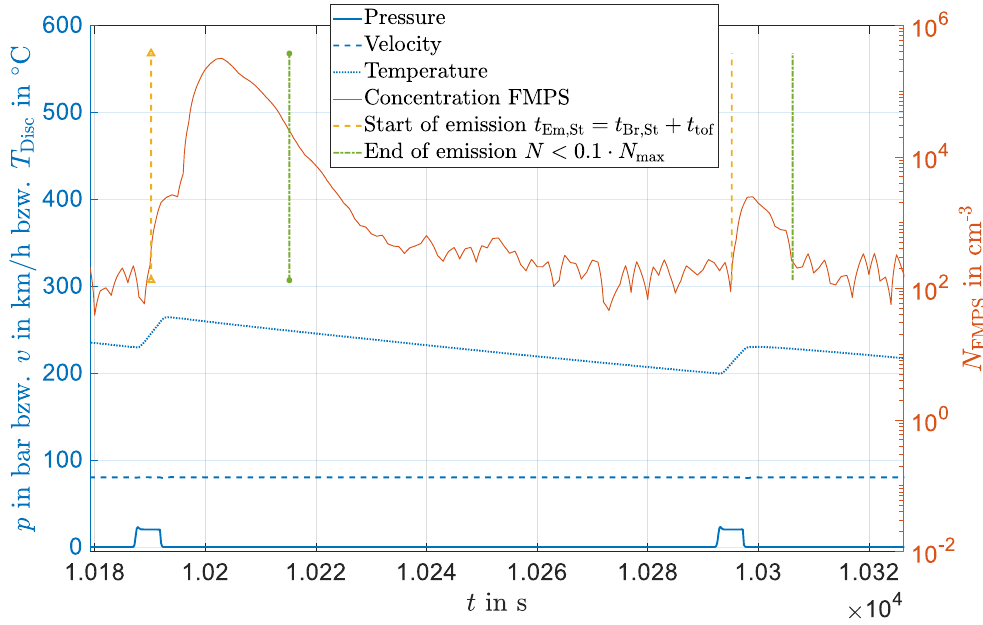
Figure A1. Calculation of emission start and emission end for the calculation of the total number of particles per brake event. Emission start is defined as the time of brake start plus the flight time of particles, which is approximately 3 s. The end of emission is defined as the time when the concentration falls below 10 % of the maximal concentration during this brake event. Due to the logarithmic plot of the concentration the area below the concentration curve is not proportional to the number of particles.